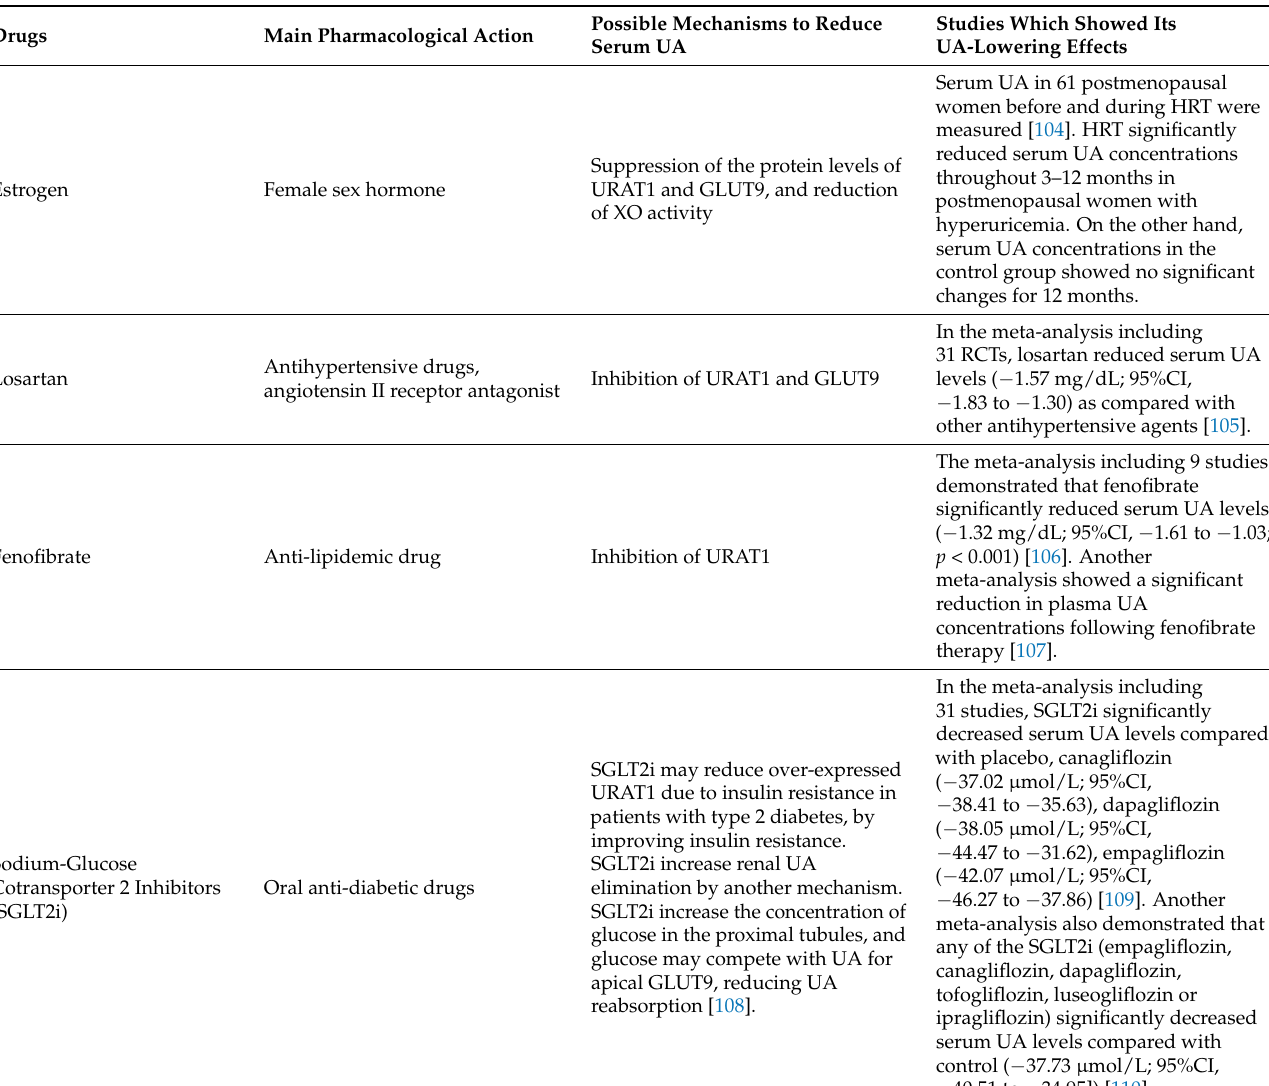
Table 2. Other Drugs to Lower Serum